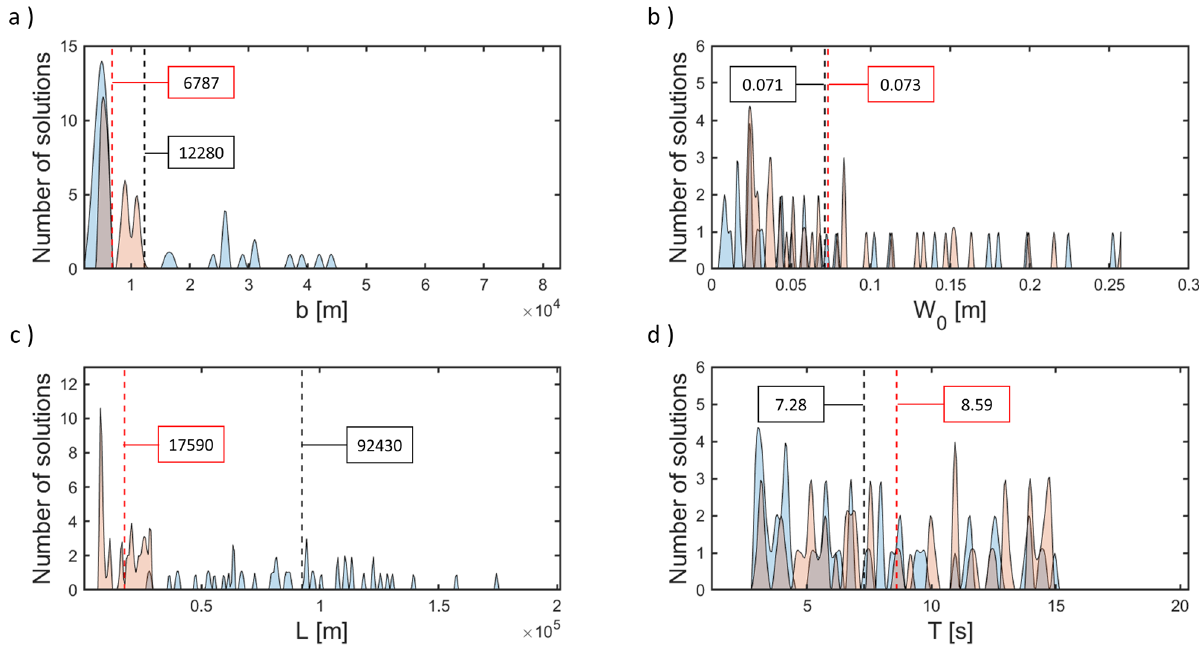
Figure 5. Probability density functions for the effective slender fault characteristics calculated by the inverse problem model. In blue, the results were calculated without taking into account the moment magnitude of the studied tectonic event; and in orange, the inverse problem model was fed with the regressions developed by Wells and Coppersmith (1994). Dashed vertical lines indicate the averaged values for each approach. ( a ) Results for the half width, b , ( b ) Results for the uplift speed, W 0 , ( c ) results for the half length, L and ( d ) results for the half duration, T